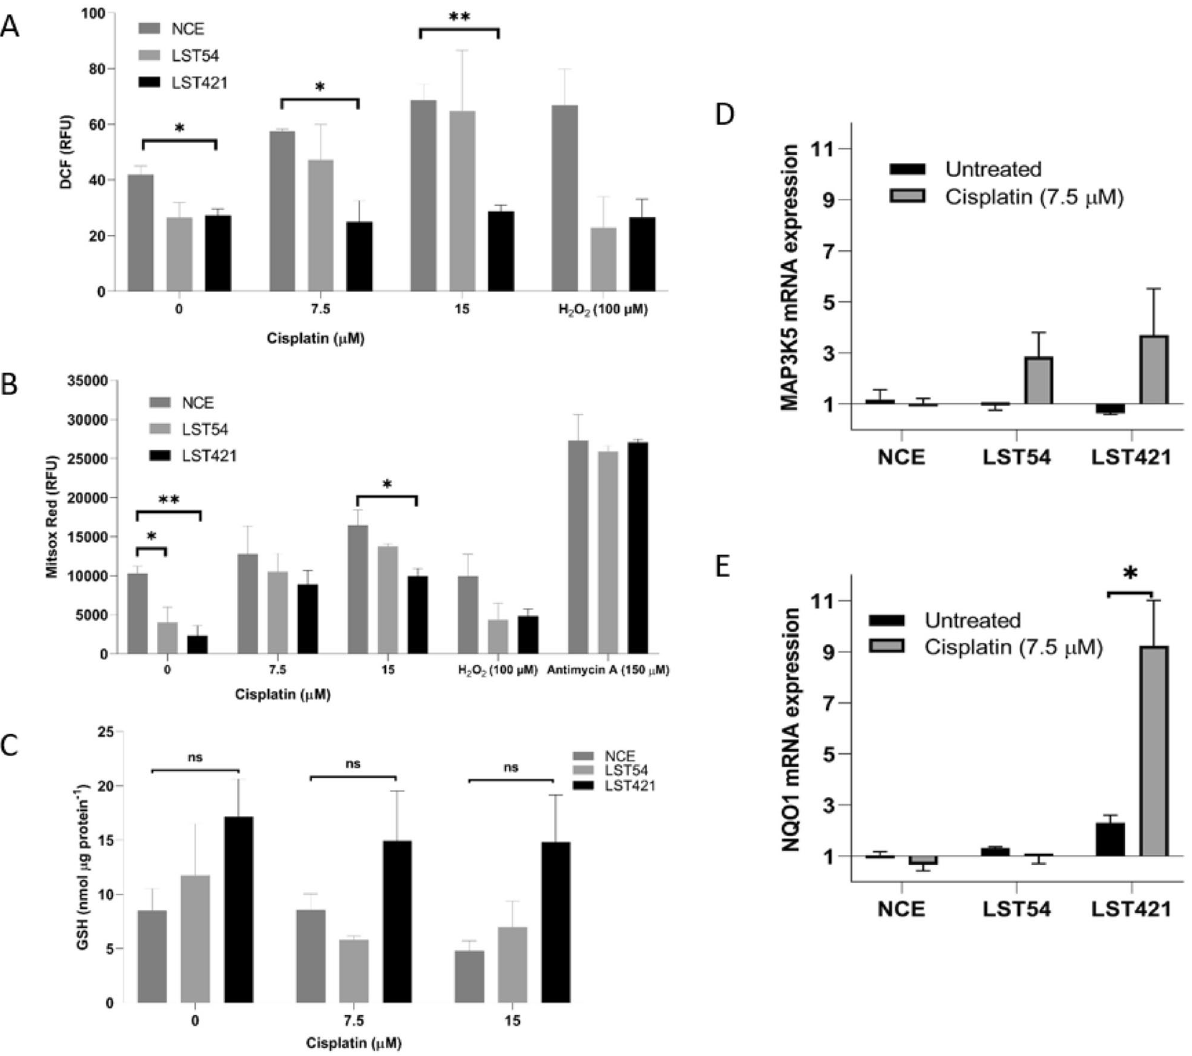
Figure 3. Cytoglobin expression protects cells from cisplatin mediated oxidative stress. Cells were treated with cisplatin 7.5 µ M and 15 µM cisplatin for 48 h. Hydrogen peroxide (100 µM, 1 h) and antimycin A (150 µM, 1 h) were used as positive controls. ( A ) Total levels of cellular ROS as assessed by oxidation of dichlorofluoroscein, ( B ) Mitochondrial levels of ROS as assessed by oxidation of Mitosox and ( C ) total intracellular levels of GSH. The results represent the mean of three experiments carried out in duplicate ± SD (n = 3). Unpaired t-test performed between LST421 and LST54 in comparison to the NCE cells. * represents p < 0.05 and ** represent p < 0.01. Cisplatin (7.5 µM, 48 h) regulation of ( D ) MAP3K5 and ( E ) NQO1 mRNA levels in control and cytoglobin expressing cells as assessed by qPCR. Wilcoxon paired test performed between the untreated and cisplatin treated cells, p < 0.05. The results represent the mean of three experiments carried out in duplicate ± SD (n = Analysis by qPCR further confirmed changes in the cellular antioxidant response in cells expressing cytoglobin. MAP3K5 also known as apoptosis signal regulating kinase 1 (ASK1) a redox regulated stress kinase was up- regulated in cytoglobin expressing cells following treatment with cisplatin (7.5 µM, 48 h, Fig. 3D). In addition, NQO1 an anti-oxidant transcript regulated by the antioxidant response element activating transcription factor Nrf2 was significantly over-expressed in cells expressing high levels of cytoglobin (Fig. 3E). These data suggest that cells expressing cytoglobin have a greater anti-oxidant signalling response following cisplatin and this may explained the reduction in parameters related to oxidative stress observed. To further investigate changes to mitochondria, cells were stained with fluorescent mitotracker dye. In both control and cytoglobin expressing cells mitochondria demonstrated a typical elongated tubular structure. Fol- lowing treatment with cisplatin (7.5 µM, 48 h), control cells contained small rounded mitochondria indicative of oxidative stress-induced mitochondrial fission (Fig. 4A,B). In contrast, in cells expressing cytoglobin there was at least partial preservation of normal mitochondrial morphology (Fig. 4A,B). This was confirmed by quantifying the number of mitochondria as discrete particles in threshold images (Fig. 4C), analysed using ImageJ.